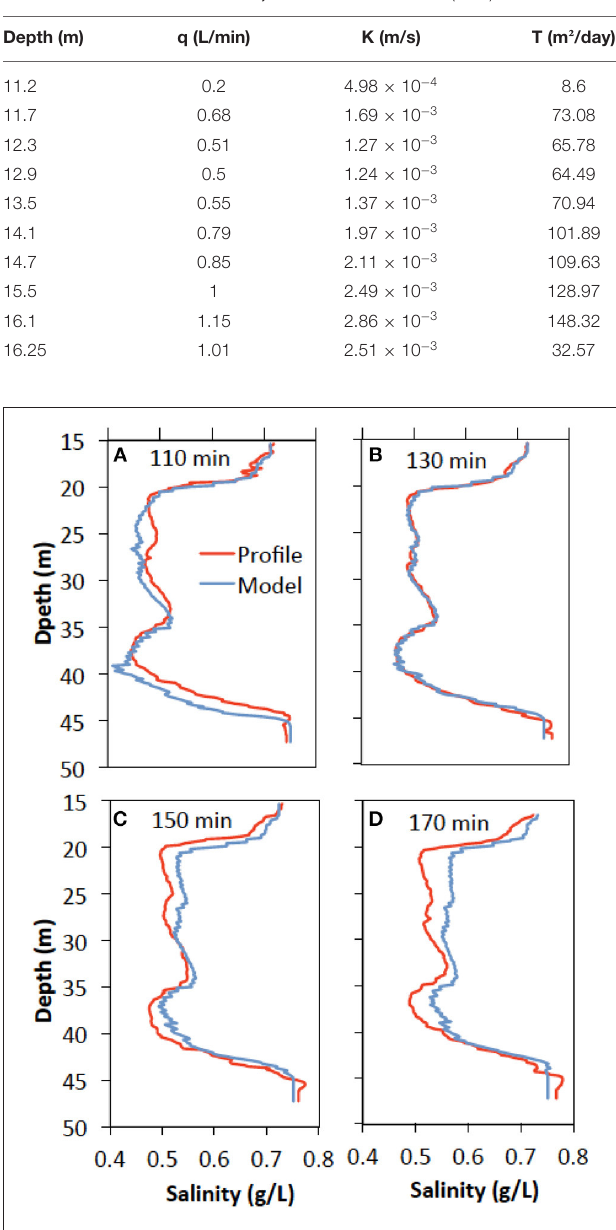
FIGURE 10 | Modeling of selected profiles for the NUC well at: (A) 110min, (B) 130min, (C) 150min, and (D) 170min.